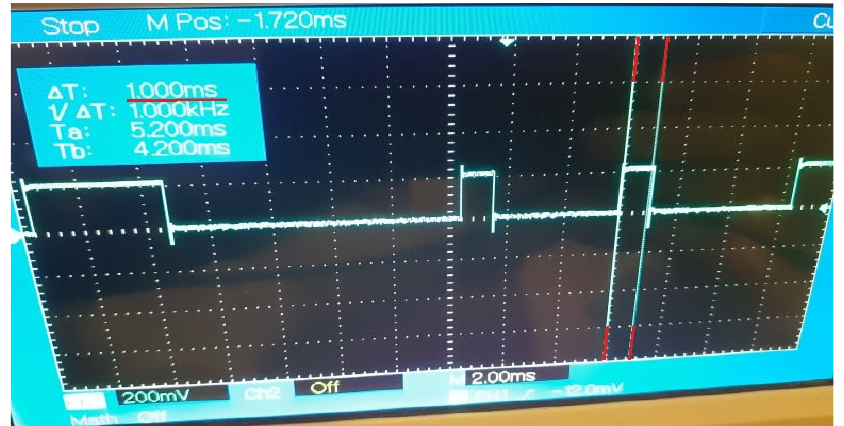
Figure 9. Generated Digital Signal based on payload delivered by the Gateway Application at 1 ms recurrence.